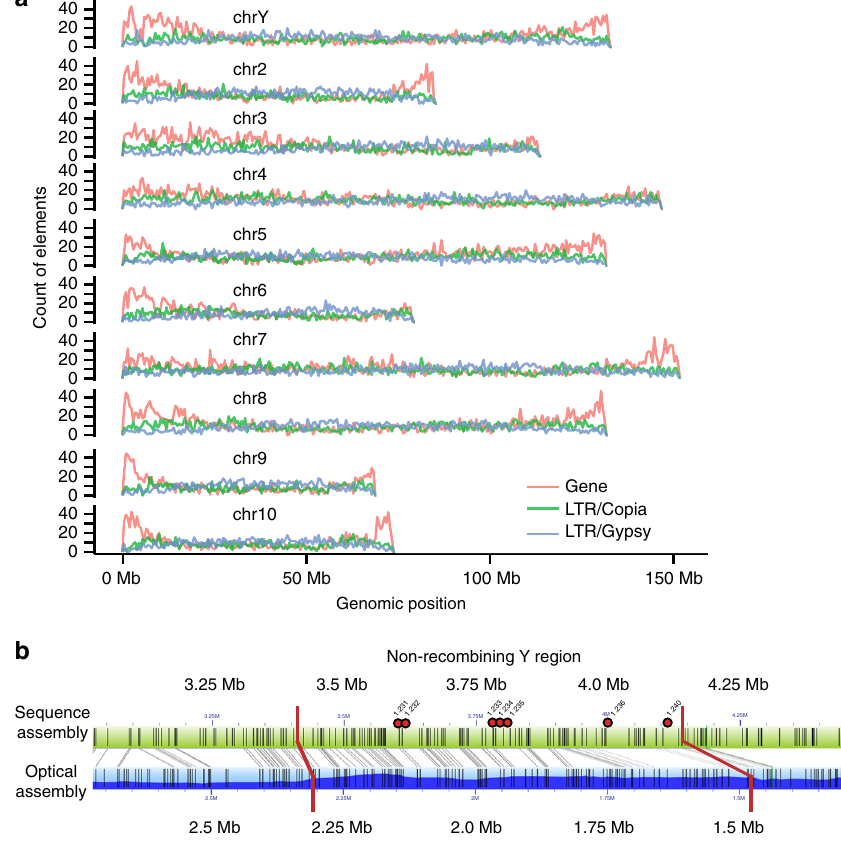
Fig. 1 Genome assembly and identi fi cation of the sex-linked region. a The distribution of full-length Gypsy and Copia- class retroelements and genes along the ten Asparagus of fi cinalis pseudomolecules in 1 Mb bins. b The alignment of the optical map against the assembled sequence contigs across the non-recombining region of the Y chromosome. Gray bars connecting the two indicate optical map BspQI nick sites that align. Red bars indicate putative boundaries for the non-recombining region on the Y chromosome. Seven gene models within the contiguously assembled region are numbered with red dots above the sequence assembly. Six additional hemizygous gene models were placed in this recombination bin but are in contigs that could not be anchored onto the optical map (Table